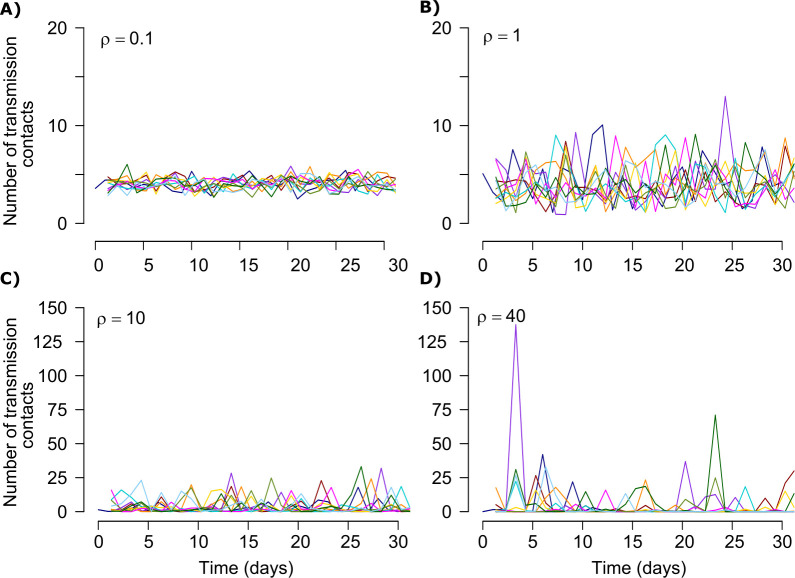
Stochastic simulations of the number of exposure contacts over time for varying dispersion (ρ).The average number of exposed contacts is 4 per day in each example with imputed daily heterogeneity based on an elevated value of ρ. The number of exposure contacts at any time ‘t’ is drawn from a gamma distribution ηt~Γ(4/ρ, ρ). Different colored lines represent multiple instances of the number of exposure contacts over 30 days using the gamma distribution.